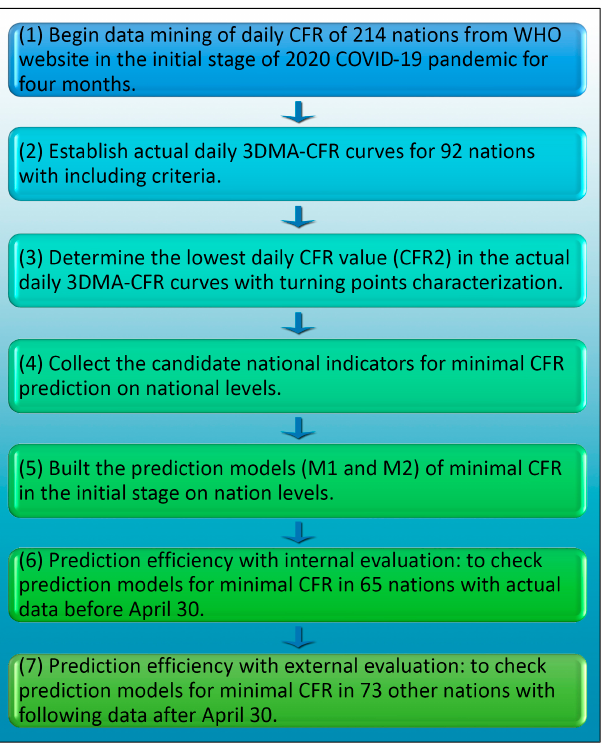
Figure 1. Illustration for modelling and prediction of national minimal CFR value in the initial stage of epidemic with national indicators. 2. Materials and Methods 2.1. Data Source of Actual Daily CFR for All